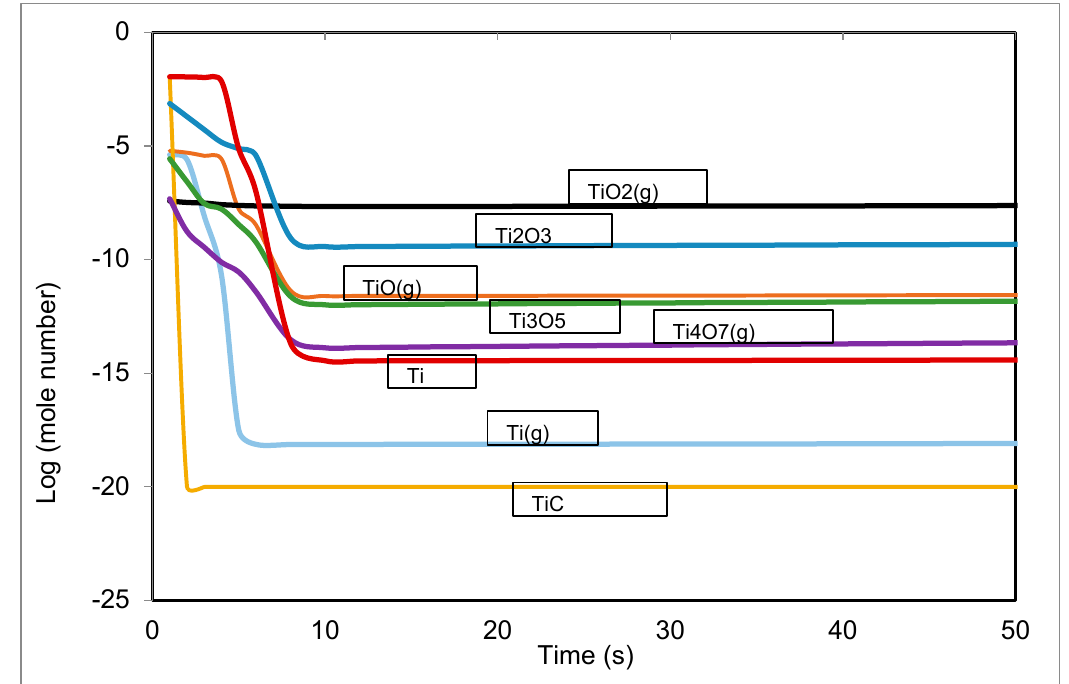
Figure 6. Variation of the mole number of titanium components in the liquid and gas phase.